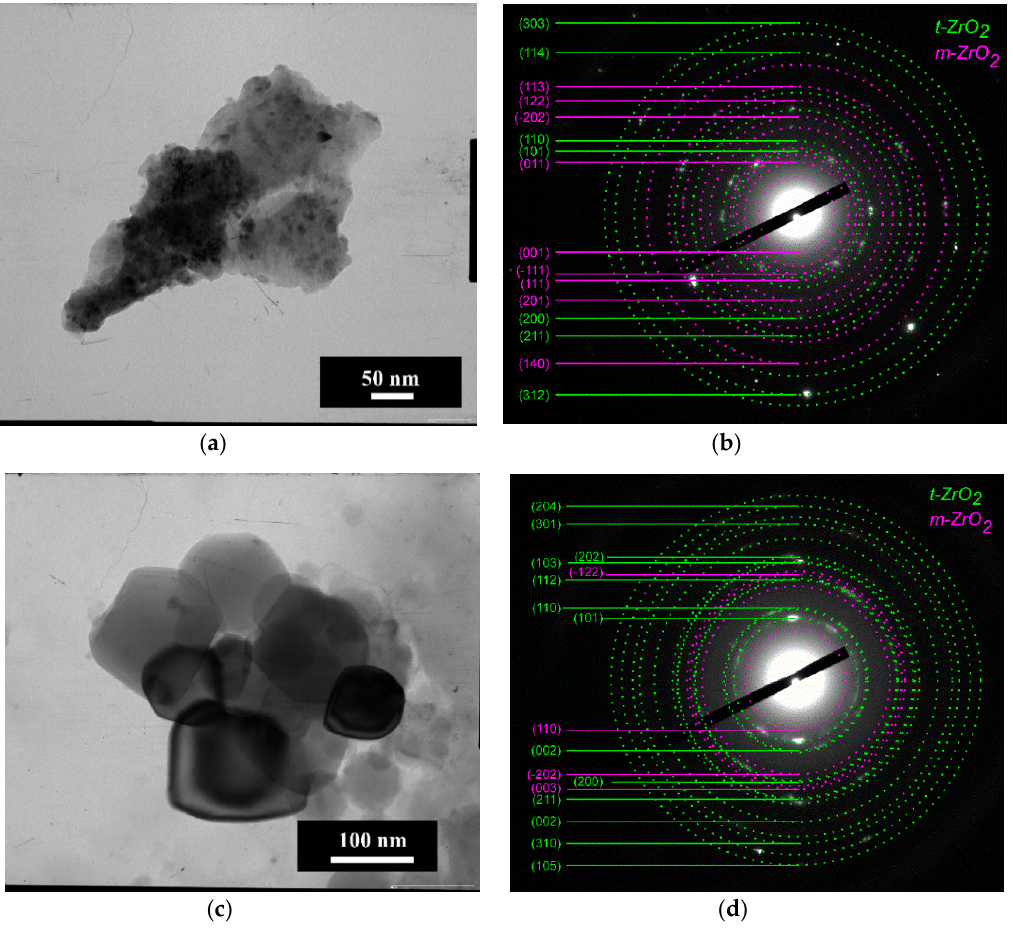
Figure 9. TEM images of 3Y-TZP-Al 2 O 3 ceramics syntered at 1400 °C: ( a ) composition I; ( c ) composition II and Millers lines of the corresponding ceramics ( b , d ).